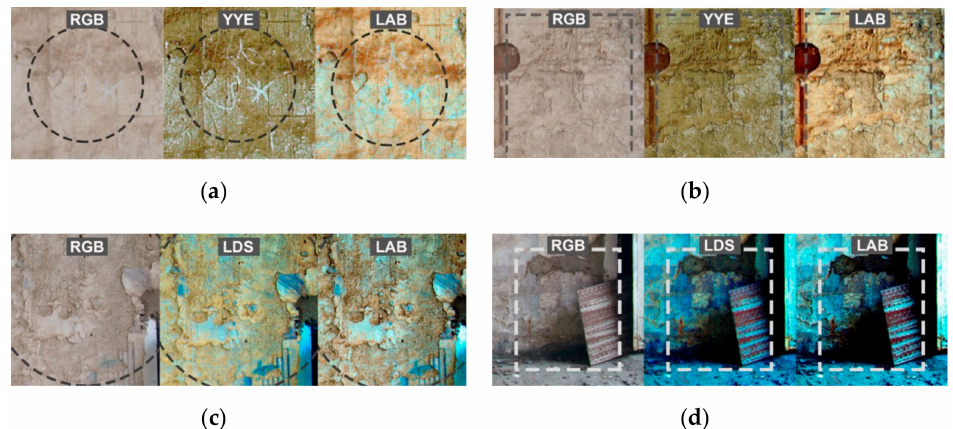
Figure 11. Details revealed by DStretch ® on the right-hand panel (RW). ( a ) Contemporary gra ffi ti; ( b ) square-shaped decoration; ( c ) blue ornamental elements flanking the entry door; ( d ) lower section of central pilaster.